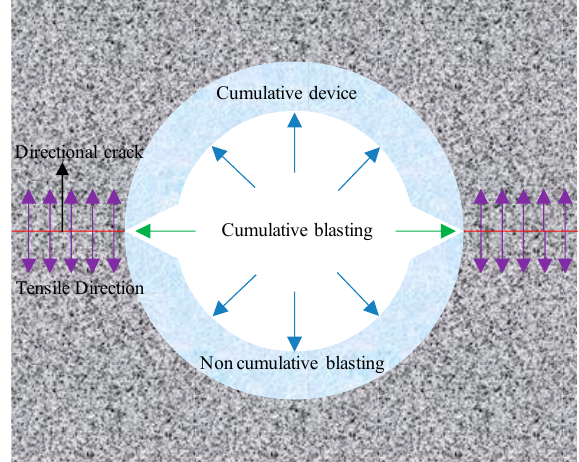
Figure 17. Principles of the directional roof-cutting technique.